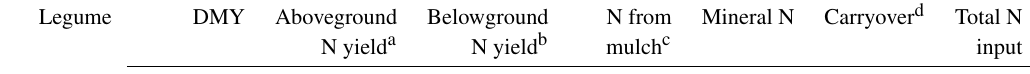
Table 1. N inputs from forage legumes and fertilization per treatment. Shown are mean values ( n = 4 ± standard error). Legume DMY Aboveground Belowground N from Mineral N Carryover d Total N N yield a N yield b mulch c input kgNha − 1 2015 Crotalaria 3w 1516 ± 183 53 . 3 ± 6 . 4 17 . 7 ± 2 . 1 26 . 6 ± 3 .